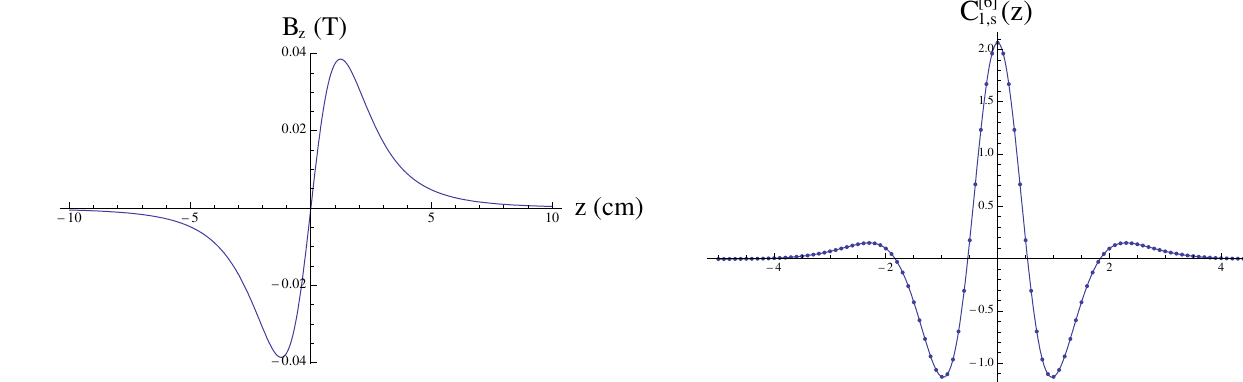
FIG. 10. (Color) The field component B (cid:2) ¼ (cid:4)= 4 , z 2 ½(cid:1)1 ; 1(cid:3) for the monopole doublet in the case that a ¼ 2 : 5 cm and g ¼ 1 Tesla - ð cm Þ 2 . The coordinate z is given in centimeters.